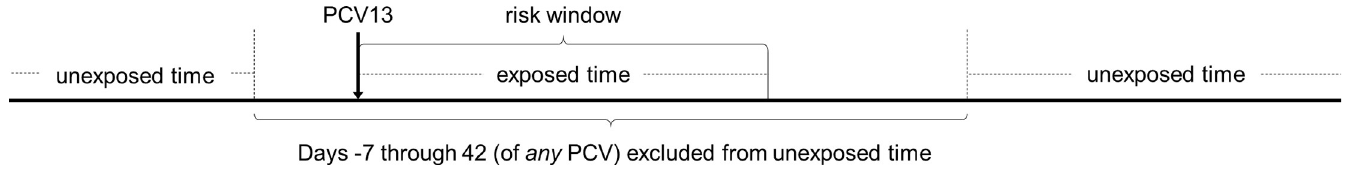
Fig 1. Illustration of segments of exposed and unexposed person-time for a PCV13-vaccinated child contributing person-time to the cohort analysis with the Days 1–28 risk interval. Person-time within the upward-pointing bracket was categorized as exposed, whereas person-time occurring outside of the downward- pointing bracket was categorized as unexposed. Person-time occurring during Days − 7 through 0 and Days 29–42 of any PCV vaccination was not included in the analysis. Likewise, Kawasaki disease cases in the cohort analysis were categorized as exposed, unexposed, or excluded depending on the time segment in which they occurred. PCV13, 13-valent pneumococcal conjugate